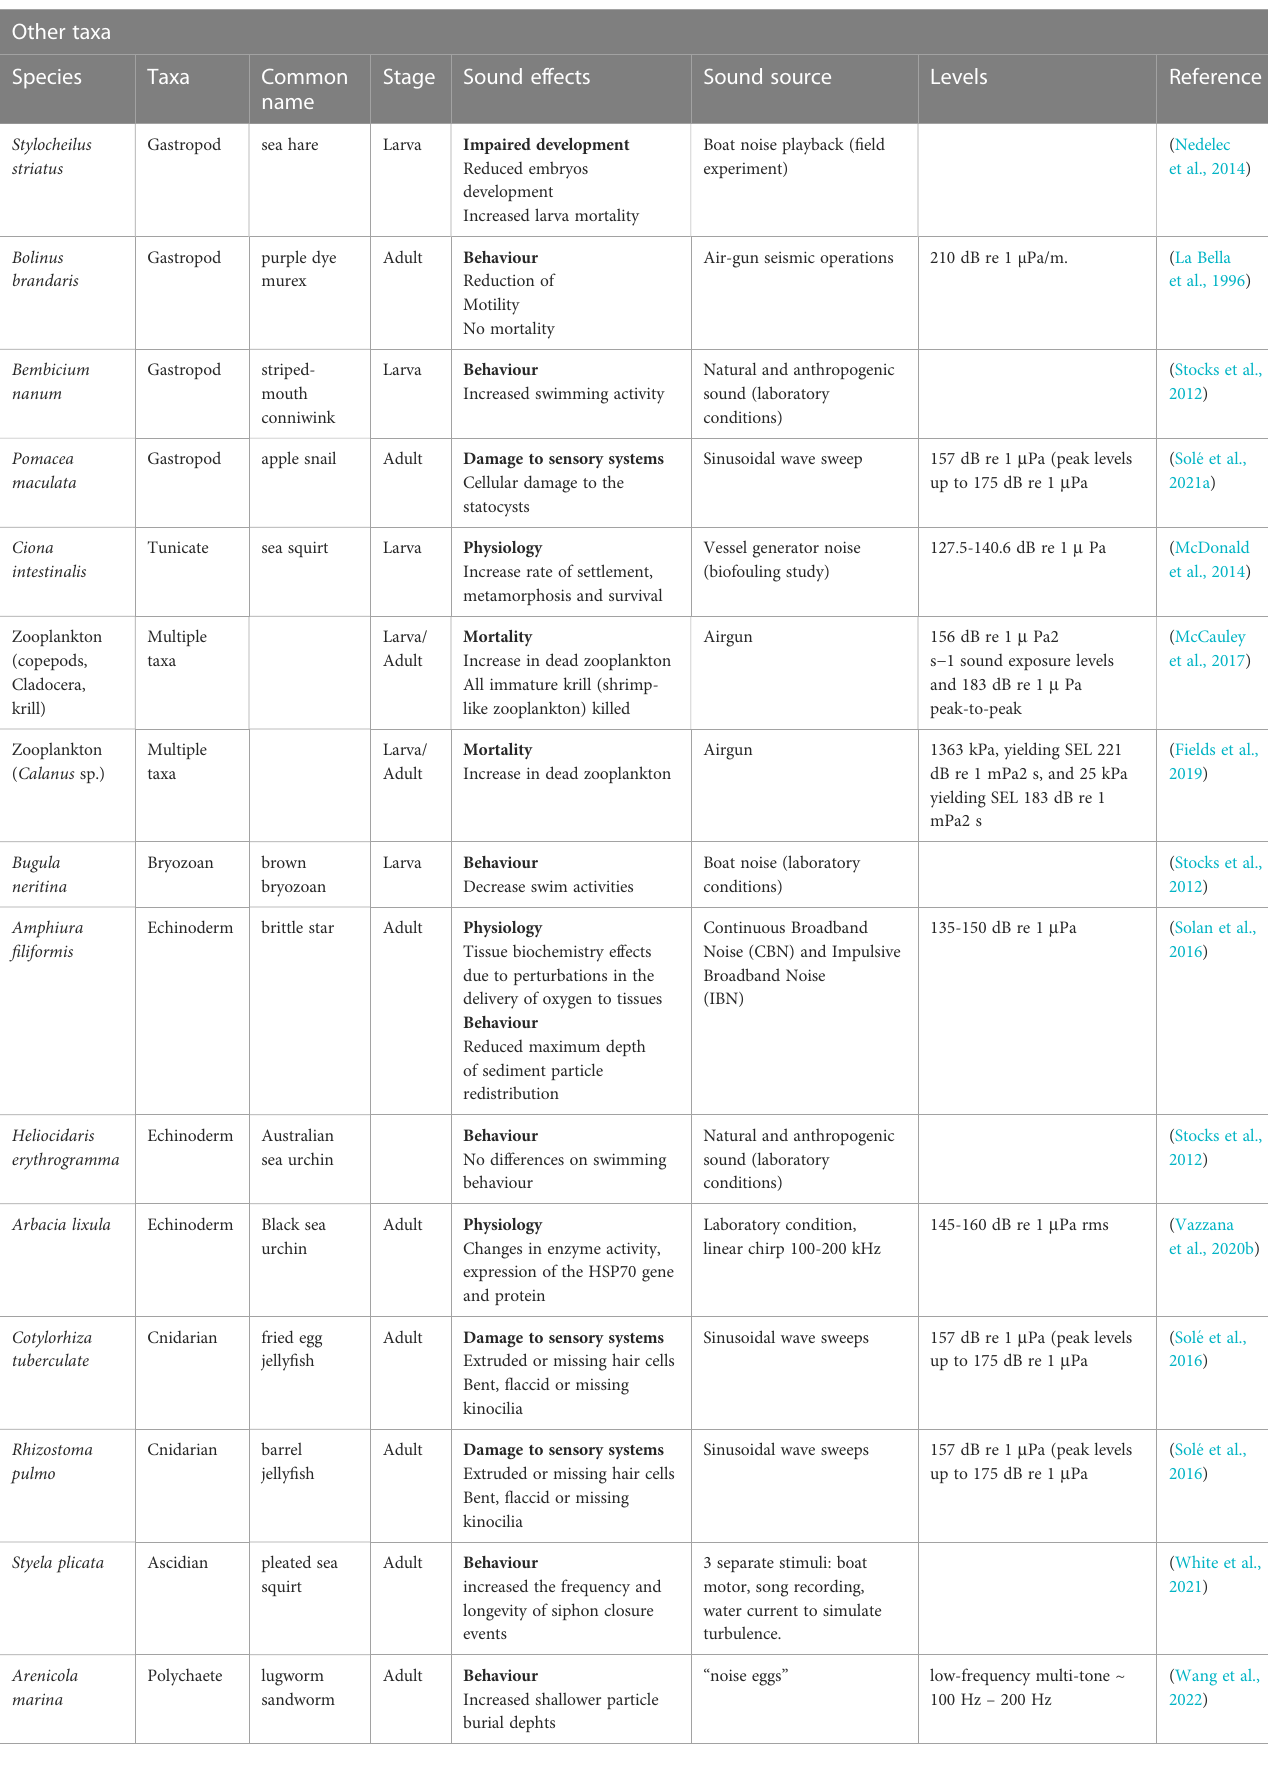
TABLE 7 Relevant studies on noise impact on Gastropods, Bryozoa, Echinoderms, Cnidarians, Tunicates and